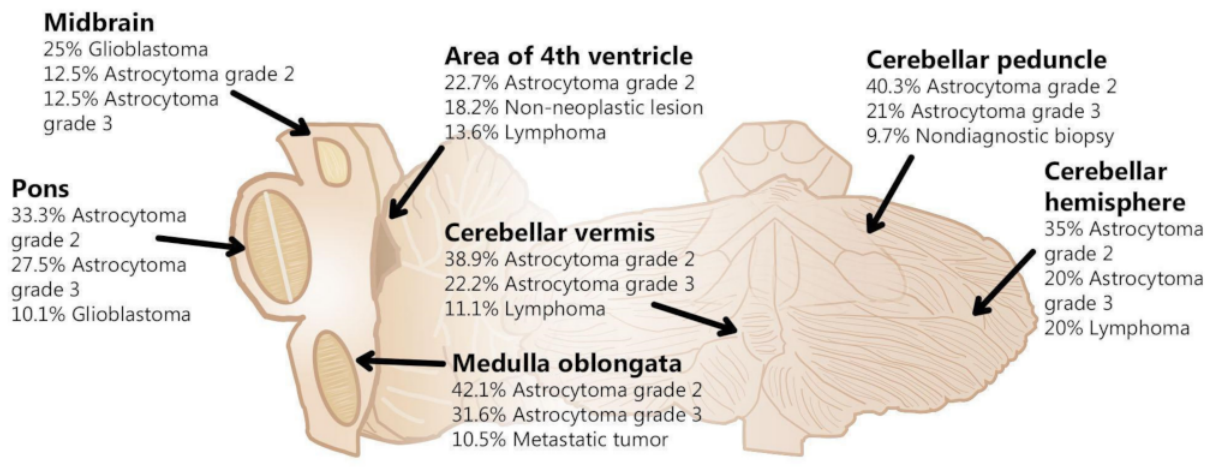
Figure 3. The frequency of diagnoses depending on lesion location.